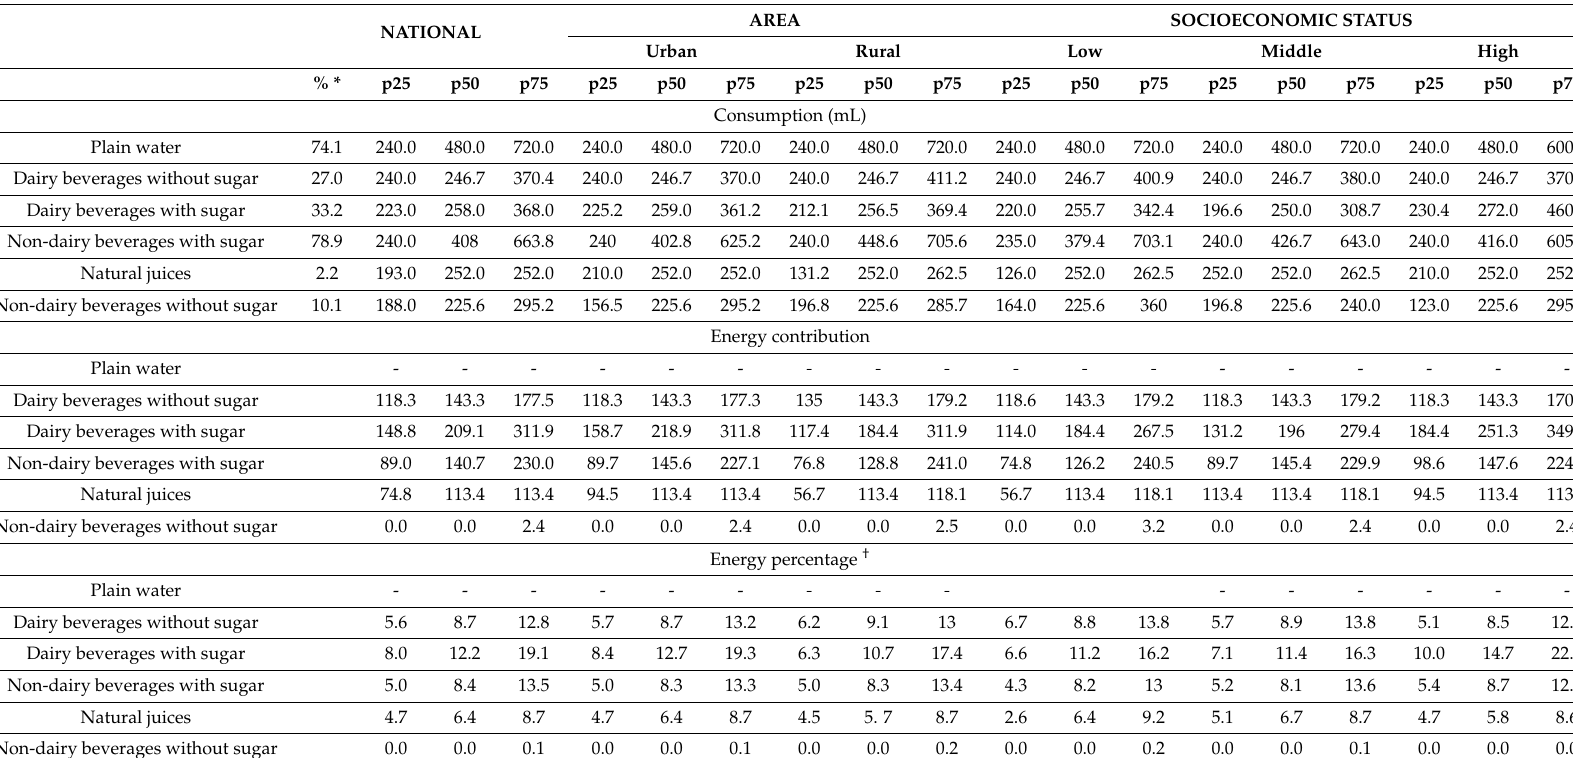
Table 4. Quartiles of consumption, energy contribution and percentage of energy of beverage groups by socioeconomic status and area of residence in Mexican school-age children ( n =